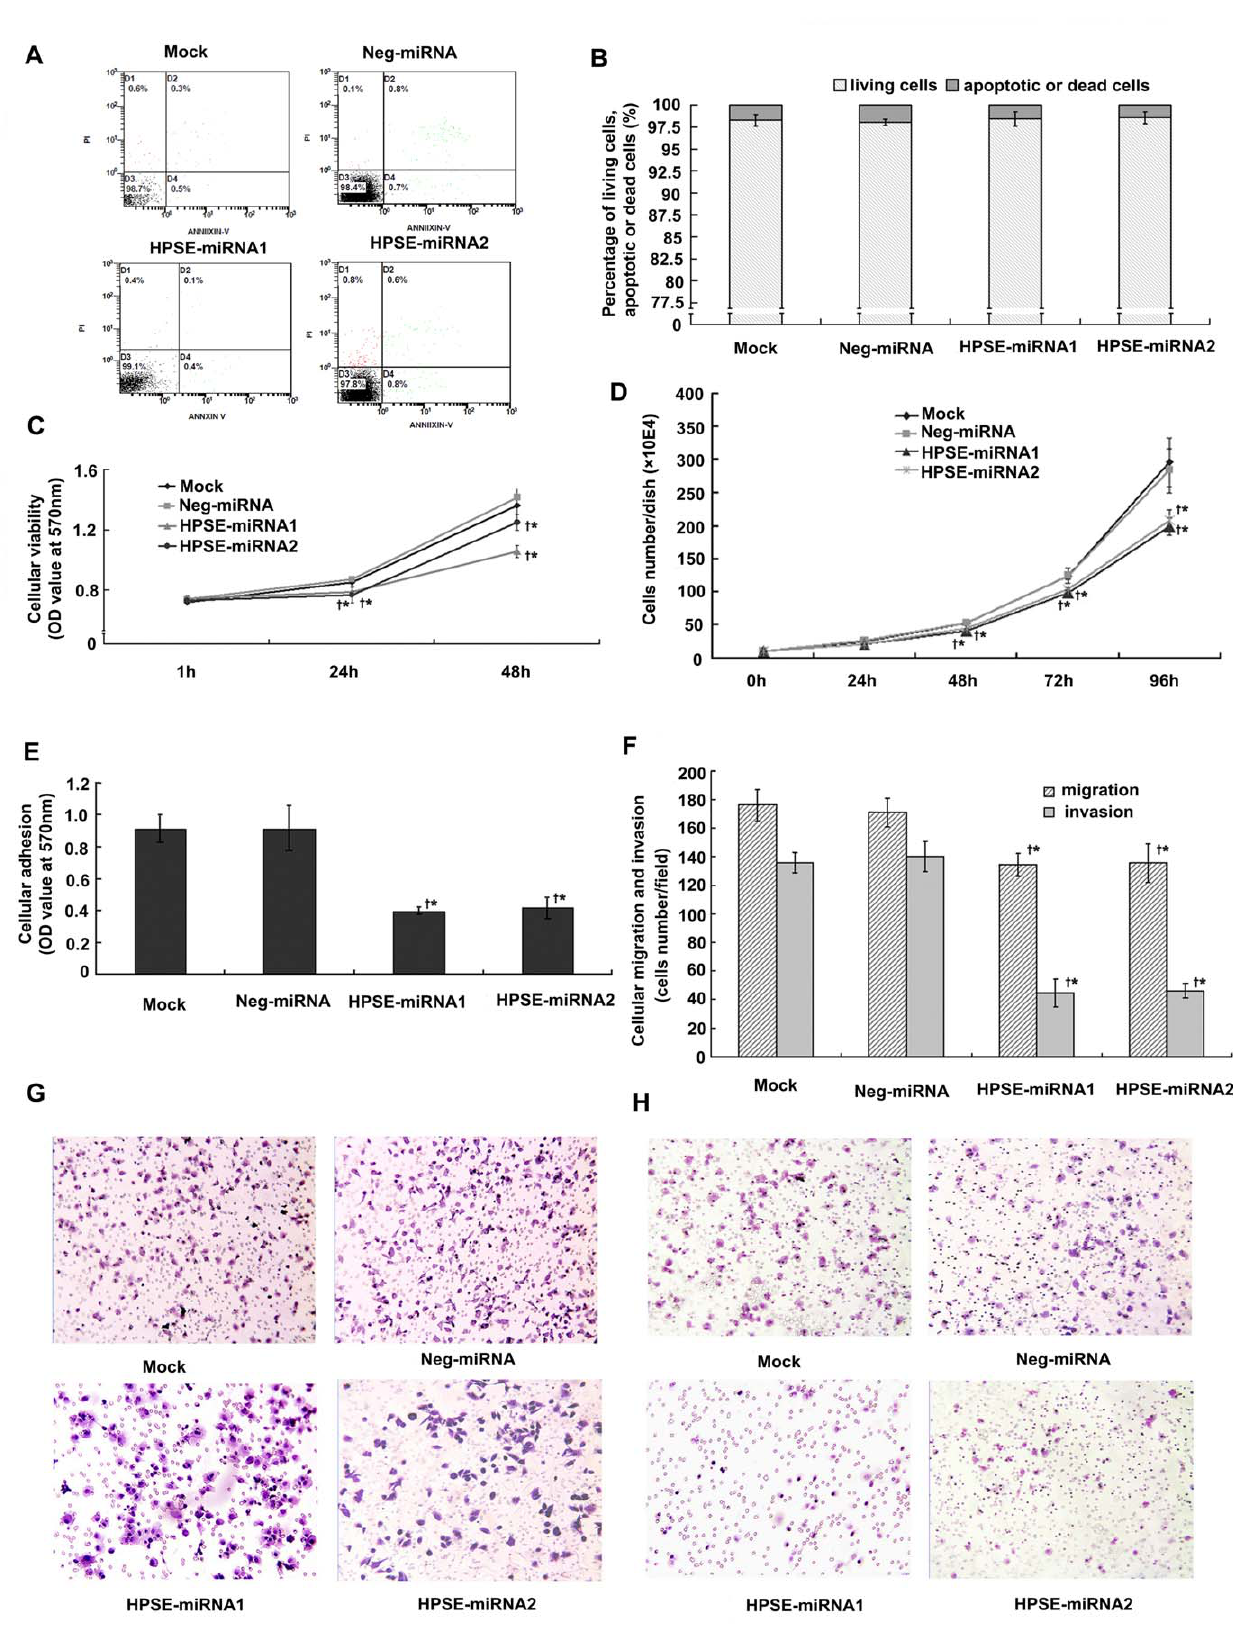
Figure 2. Effects of HPSE miRNAs on A375 cells invitro . A375 cells transfected stably with HPSE-miRNA1, HPSE-miRNA2 or Neg-miRNA were selected by blasticidin. (A-B) Flow cytometric results showed that the percentages of apoptotic cells in both HPSE-miRNA groups were not different